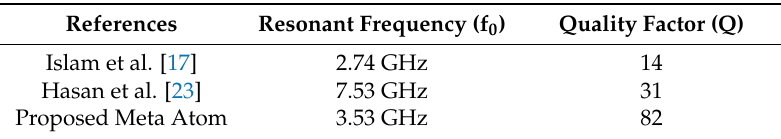
Table 7. Quality factor at the resonant frequency.